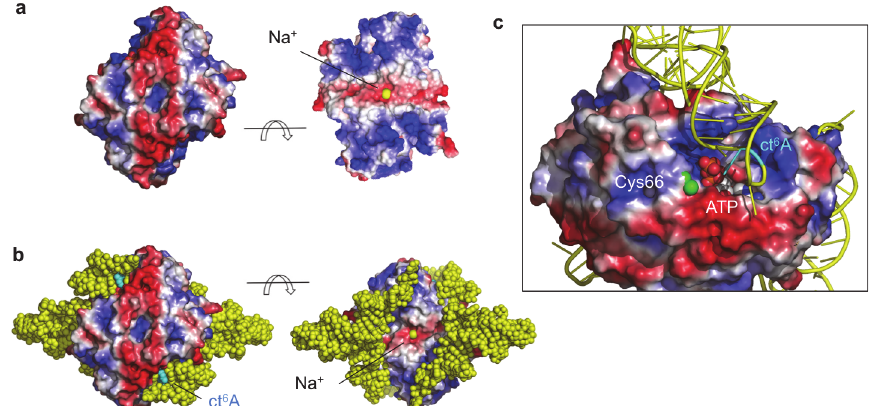
Fig 9. TcdA-tRNA interface. a Electrostatic potential molecular surface calculated with APBS (Adaptive Poisson-Boltzmann Solver) [55] and rendered with PyMOL ( www.pymol.org ) [56]. Two views are shown that are related by a 90° rotation around a horizontal axis. The interfacial Na + cation is depicted as a yellow sphere. b tRNA is modeled on the basis of the SAXS data for the TcdA-tRNA Lys (UUU) complex bound to the two outer rims of TcdA (represented as in a ), where most of the positively charged surface is found. The two tRNA molecules bind to spatially separated and independent surface patches in a symmetric arrangement. The modified ct 6 A37 nucleotide is shown in cyan. c Detailed view of the TcdA-tRNA binding mode. TcdA is represented as in ( a ), with Cys66 sulfur atom shown as a green sphere. The tRNA molecule on the front inserts its anticodon-stem loop into the ATP-binding pocket (in spheres and CPK colors), with ct 6 A37 (cyan) facing the catalytic